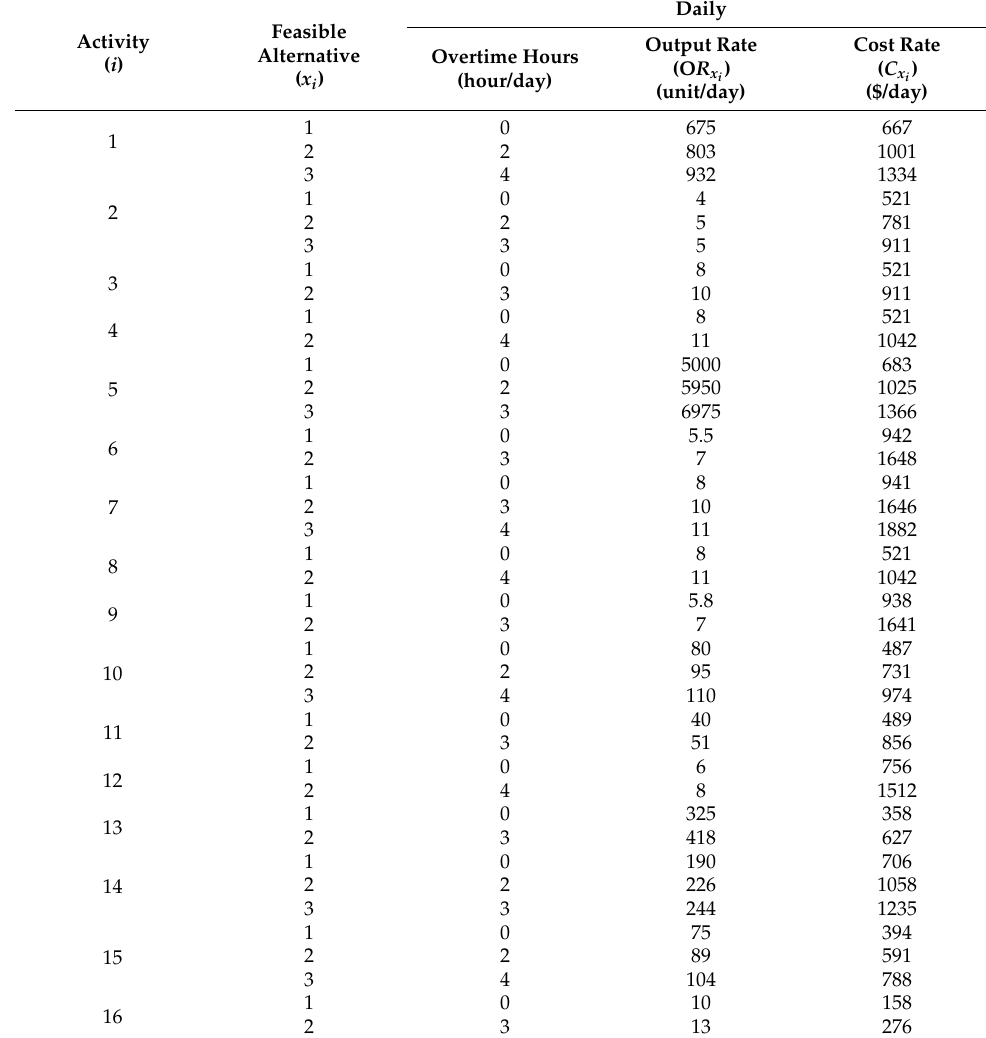
Table 2. Feasible alternatives for overtime use.